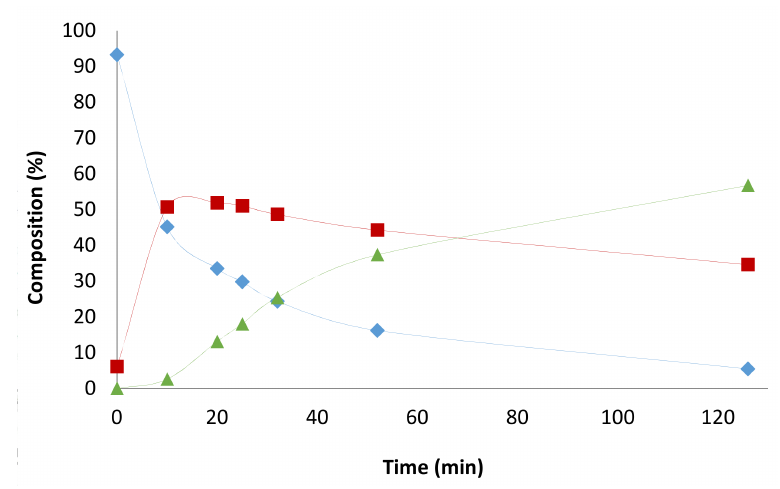
Figure A13. Composition profiles as a function of time with RhH(biphephos)(CO) 2 isolated species with ligand addition (20 equiv. vs. Rh) in toluene at [ 1 ] 0 /[Rh] = 3000 ( (cid:7) 1 , (cid:4) 1- int -x , (cid:78) 2 + 3 ) (conditions: 1 / 1- int -x (93.5:6.5) = 3.15 mmol, [ 1 ] 0 = 0.4 M, [ 1 ] 0 /[Rh] = 3000, P = 20 bar (CO/H 2 = 1:1), toluene (8 mL), T = 120 ◦ C).